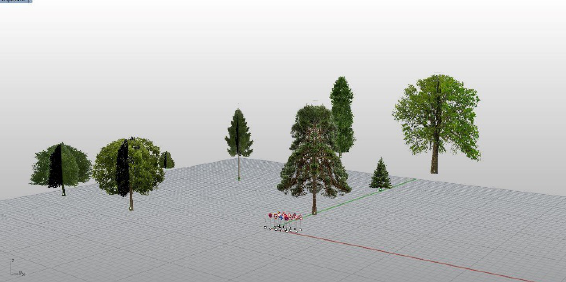
Figure 2. NURBS models.